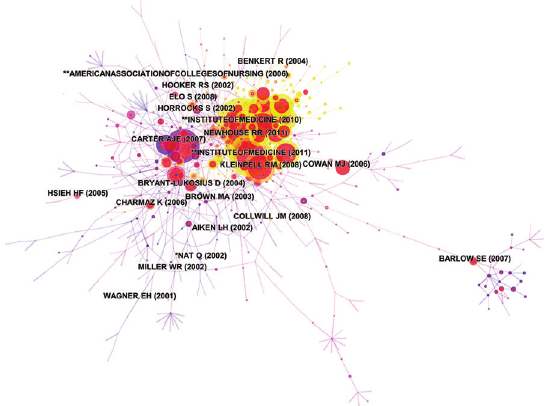
Figure 4. Knowledge map of co-cite reference in nurse practitioners.